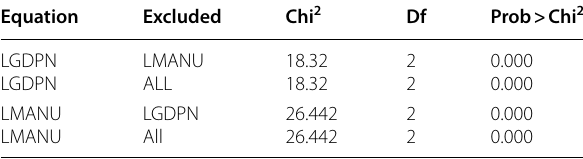
Table 5 Granger causality Wald test Table 6 Estimated results for parsimonious model of DLGDPN